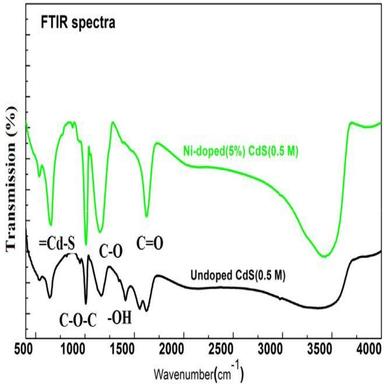
Spectra of FTIR for un-doped & Ni(5%)- doped 0.5 M CdS NP.